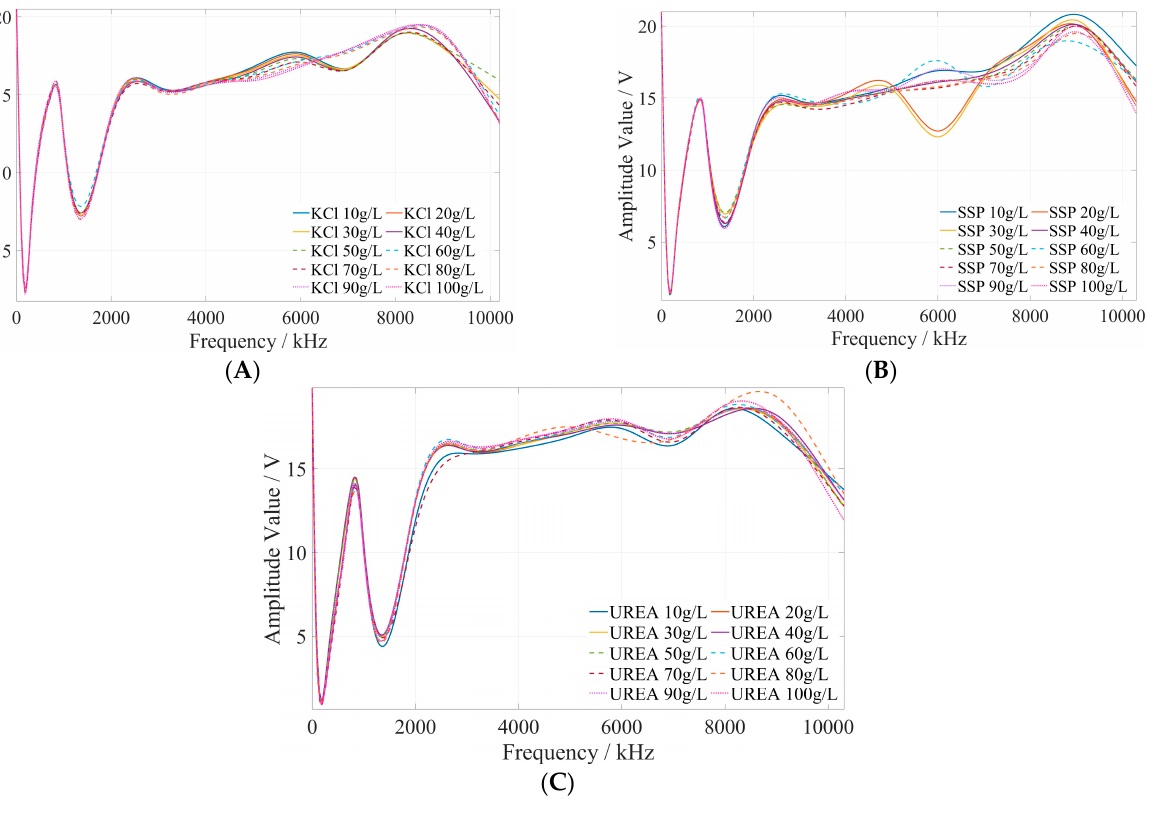
Figure 9. The amplitude–frequency characteristic curve of potassium chloride, superphosphate, and urea fertilizer solutions under the excitation signal of 1 kHz~10 MHz. ( A ) Potassium chloride fertilizer solution. ( B ) Calcium superphosphate solution. ( C ) Urea fertilizer